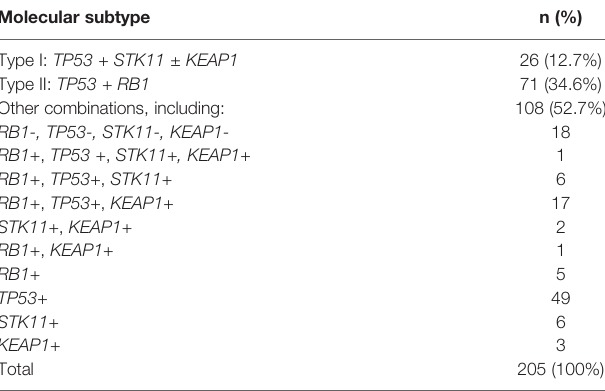
TABLE 4 | Results of a review of LCNEC molecular